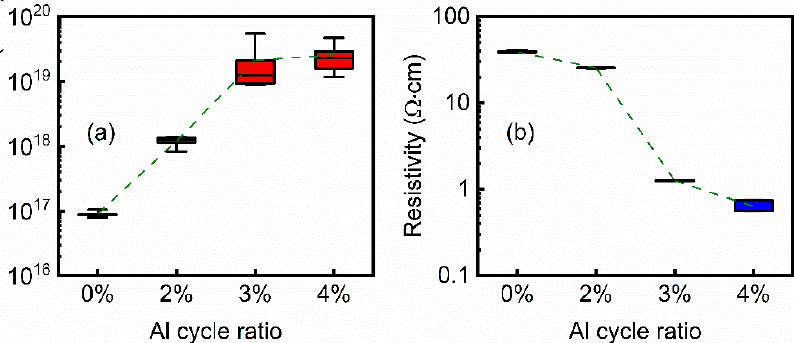
Figure 2. ( a ) Electron concentration of ZnO and AZO films. ( b ) Resistivity of ZnO and AZO films. n = 5. ZnO and AZO films were deposited on glass substrates. n = 5. ZnO and AZO films were deposited on glass